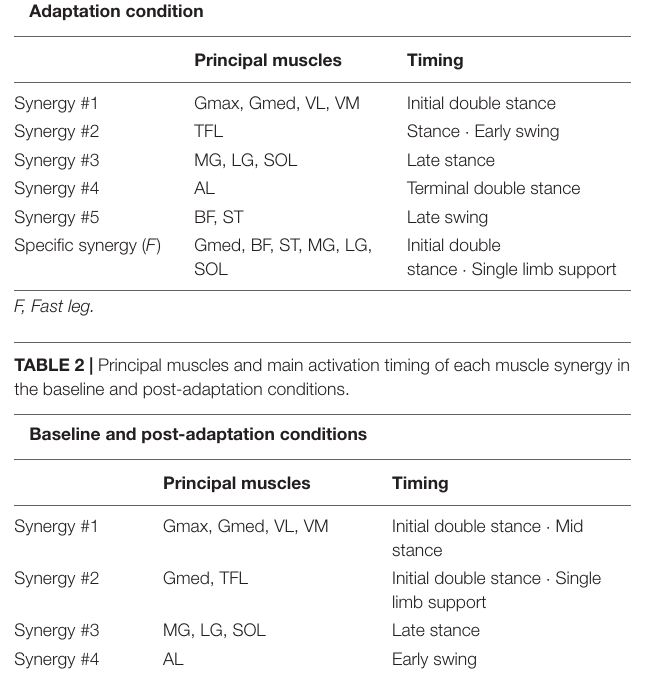
TABLE 1 | Principal muscles and main activation timing of each muscle synergy in the adaptation condition. Adaptation condition